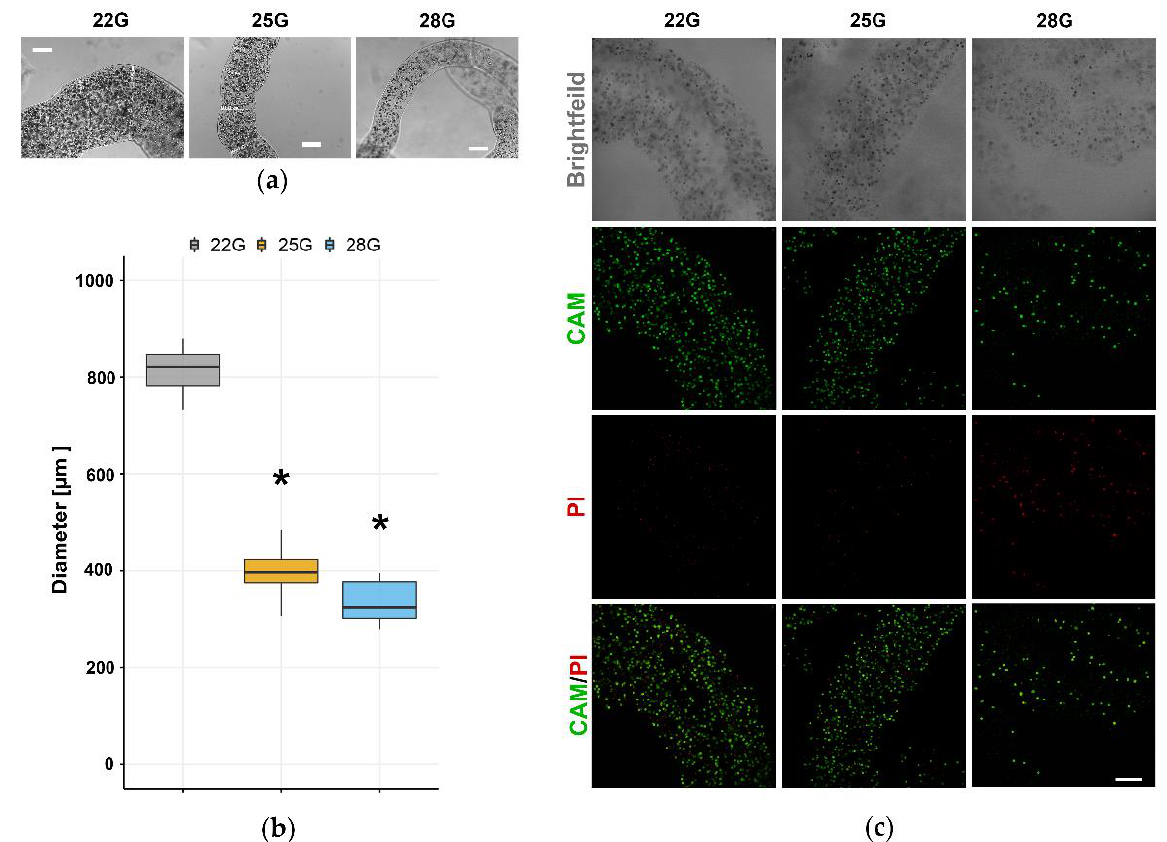
Figure 2. Selection of the optimal alginate microfibers size for long-term 3D culturing. U87 cells were immobilized in alginate microfibers by using different blunt edge stainless steel needle sizes (22, 25, and 28 G). ( a ) Brightfield images were used to determine the microfiber diameter and the results are presented as a ( b ) box-plot. ( c ) LIVE/DEAD monitoring of U87 cells in alginate microfibers stained with CAM/PI was performed by confocal microscopy. Images show live cells labeled with CAM (green) and dead cells labeled with PI (red). Scale bar = 200 µ m. All experiments were performed at least three times ( n ≥ 3). * indicates p < 0.05 statistical difference compared to the 22 G blunt edge stainless steel needle.